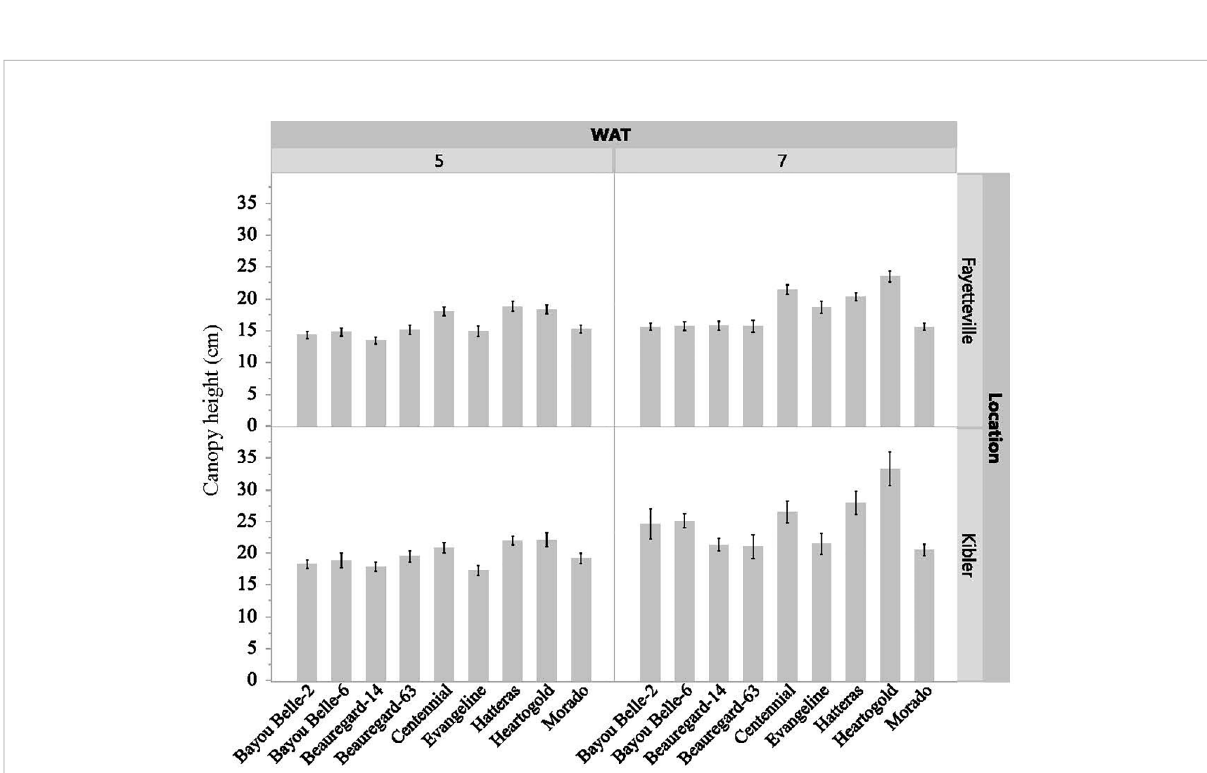
FIGURE 4 Sweetpotato canopy height (cm) averaged across weed species at 5 and 7 weeks after transplating (WAT) in Kibler and Fayetteville, AR, 2021. LSD to compare cultivars within location Fayetteville at 5 and 7 WAT: 1 cm; 1 cm. LSD to compare cultivars within location Kibler at 5 and 7 WAT: 1 cm; 2 cm. Bars represent standard